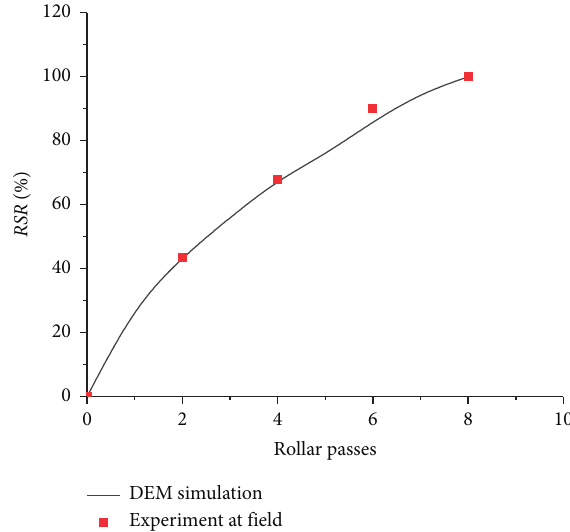
Figure 14: RSR of the rockfill pavement in the verified simulations (Case A).